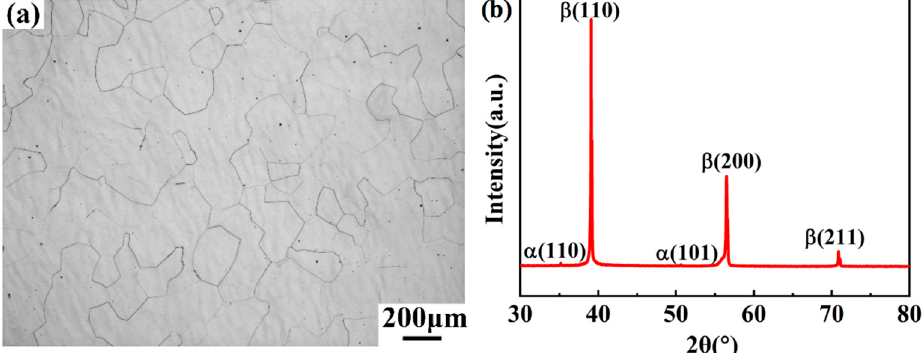
Figure 1. ( a ) Optical microstructure of the Ti-35421 alloy solution treated at 860 °C for 30 min and ( b ) its X-Ray diffraction pattern.